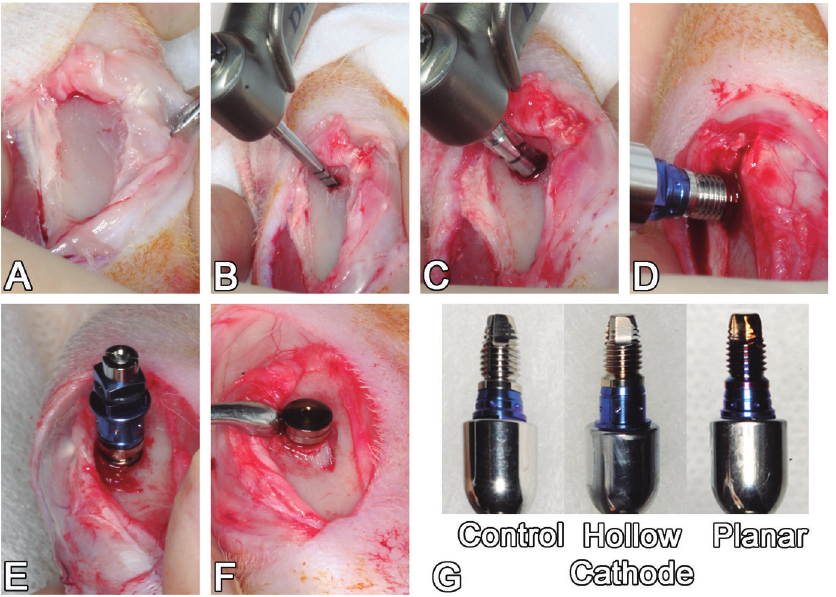
Figure 1- Surgical procedure for implant placement. Total thickness incision and surgical site exposure at the anteromedial region of the tibia (A); drilling the surgical site (B-C) and implant insertion (D-F); View of the implants